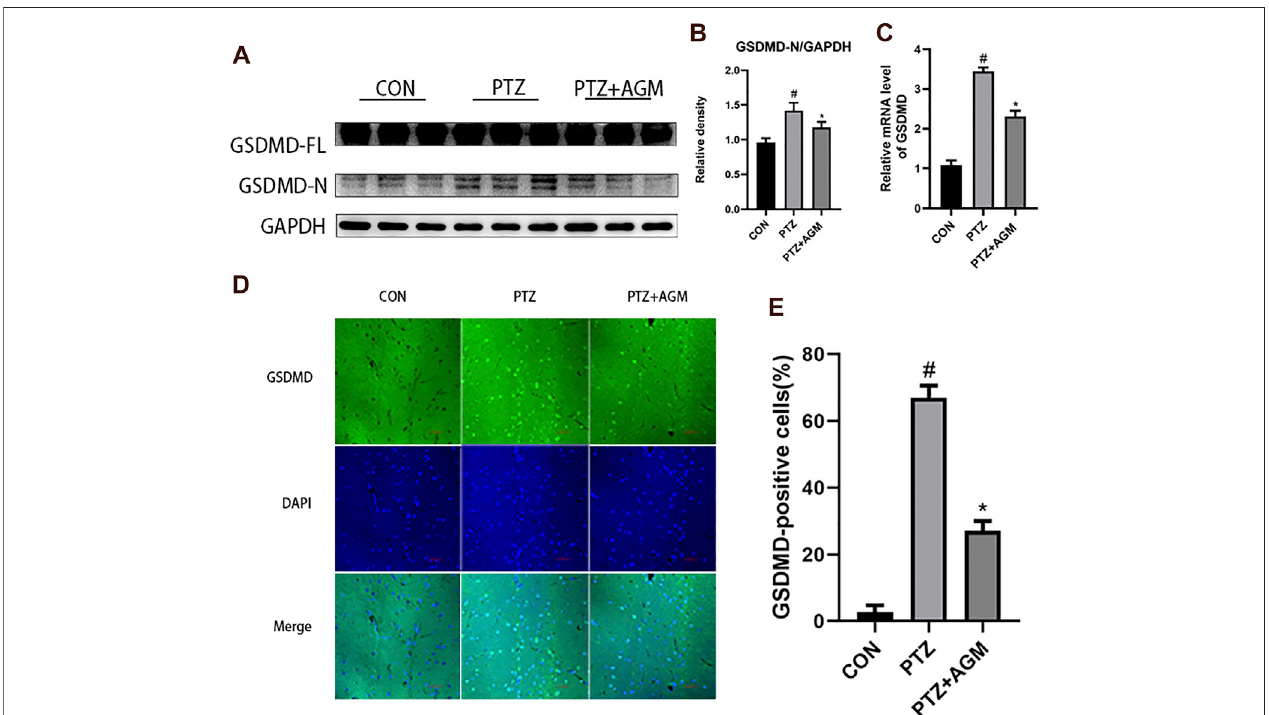
FIGURE 3 | Effects of AGM on hippocampal GSDMD protein and mRNA in PTZ-induced kindling mice. (A – B) Proteins expression level of GSDMD-FL and GSDMD-N in different groups (n (cid:1) 4 mice per group, Student ’ s test). (C) mRNA expression level of GSDMD in different group (n (cid:1) 4 mice per group, Student ’ s test). (D) Representative imagines (original magni fi cation, × 400) showing AGM inhibited hippocampal neuronal GSDMD proteins expression induced by PTZ kindling. Scale bar (cid:1) 100px. (E) Semi-quantitative analysis of the GSDMD-positive cells (%). The percentage of GSDMD-positive cells were de fi ned as follows: 100 (count of GSDMD- positive cells/total count of cells), ( n (cid:1) 4 mice per group, Student ’ s test). All data are shown as mean ± standard deviation.# p ＜ 0.05 vs the control and PTZ group, * p ＜ 0.05 vs the PTZ group and PTZ + AGM